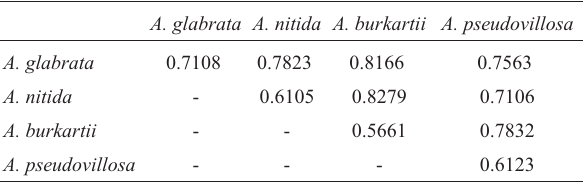
Table 4 - The mean genetic distance estimates (Nei and Li, 1979) for the four Arachis species in section Rhizomatosae . A. glabrata A. nitida A. burkartii A. pseudovillosa